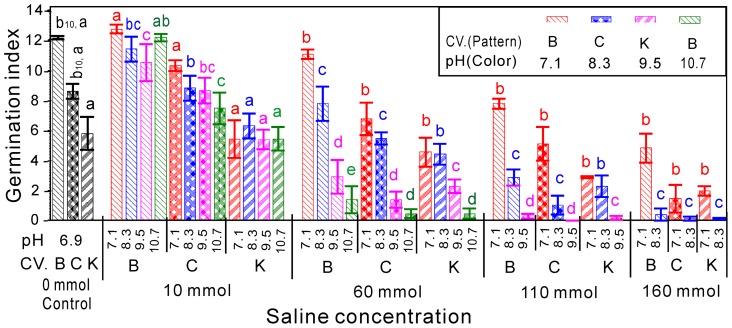
Effects of salinity and pH on the germination index.Each group of saline concentrations was separately compared with the control within the cultivar. The letters indicate differences at P<0.05 within the groups. B, C and K correspond to the capitalized the first letter of the switchgrass cultivars Blackwell, Cave-In-Rock and Kanlow.